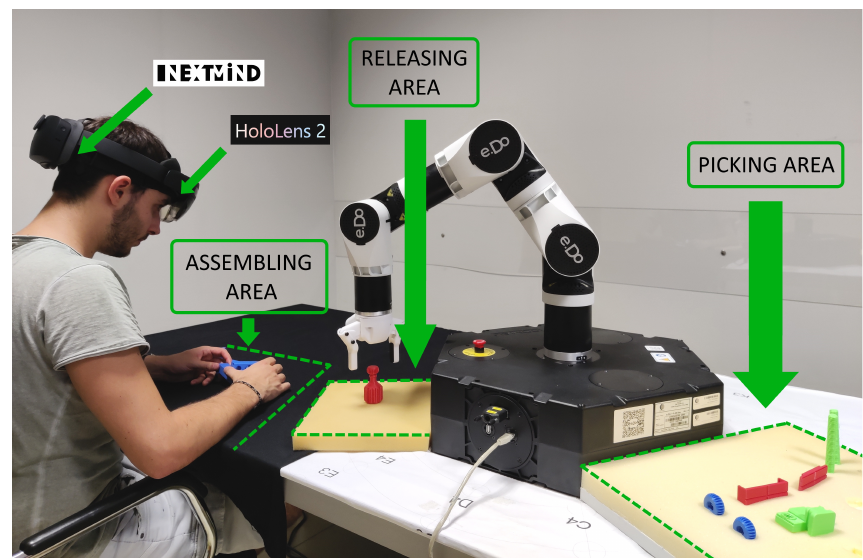
Figure 4. A screenshot representing the test setup. The user wears both the NextMind and the HoloLens 2; the pick area is visible at the right of e.Do, and the place zone is between the user and the robot.